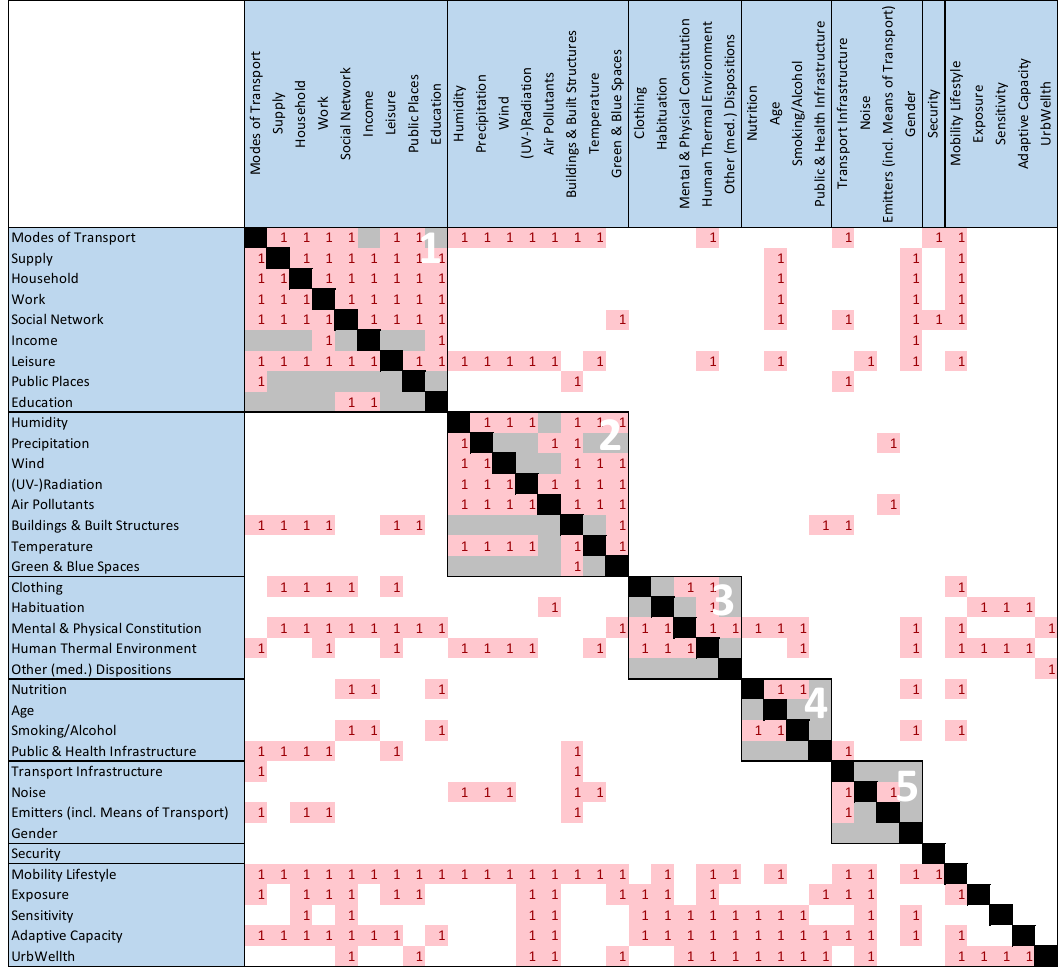
Figure 4. Clustered ( α = 0.6) Design Structure Matrix (DSM) with cluster numbers in white.